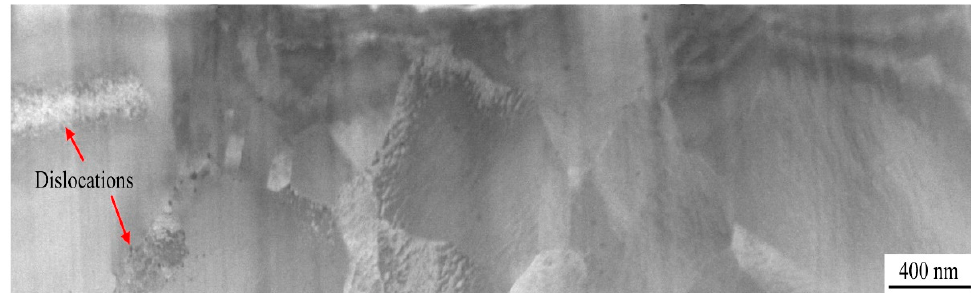
Figure 7. TEM image of the welding interface for the joint with alcohol processed at 0.55 MPa welding pressure.